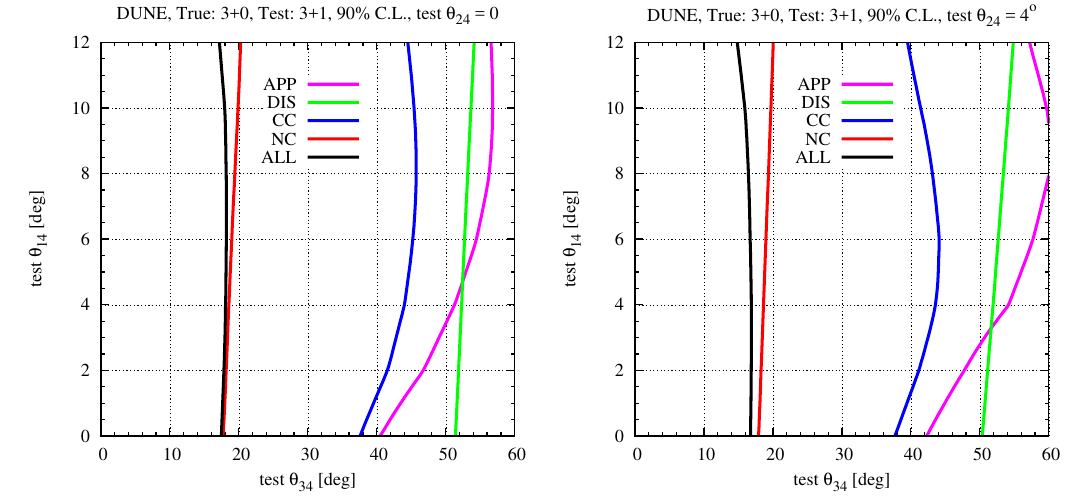
Figure 9 . 90% ((cid:1) (cid:31) 2 = 4 : 61) C.L. contour plots in the test (cid:18) 14 -test (cid:18) 34 plane for di(cid:11)erent choices of test (cid:18) 24 . Left: test (cid:18) 24 = 0 and Right: test (cid:18) 24 = 4 (cid:14) . The true case has been taken to be 3+0 and the test case is 3+1. The value of test (cid:1) m 2 is 1eV 2 for both the plots. The results are 41